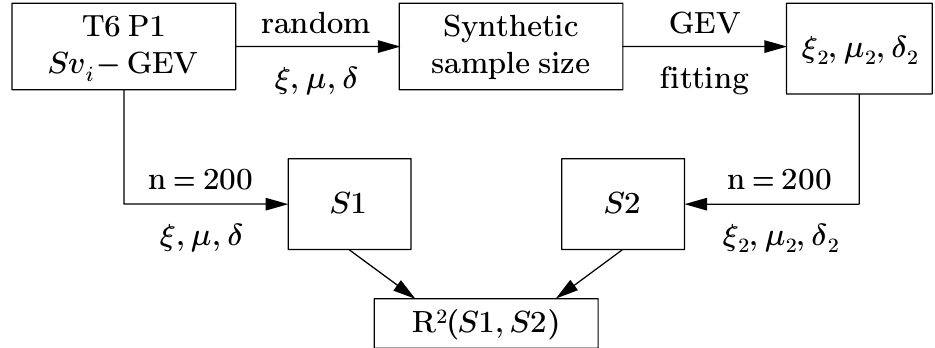
Figure 15. Workflow of the R 2 ( S 1, S 2 ) evaluation exemplified for the T6 P1 Sv i -GEV